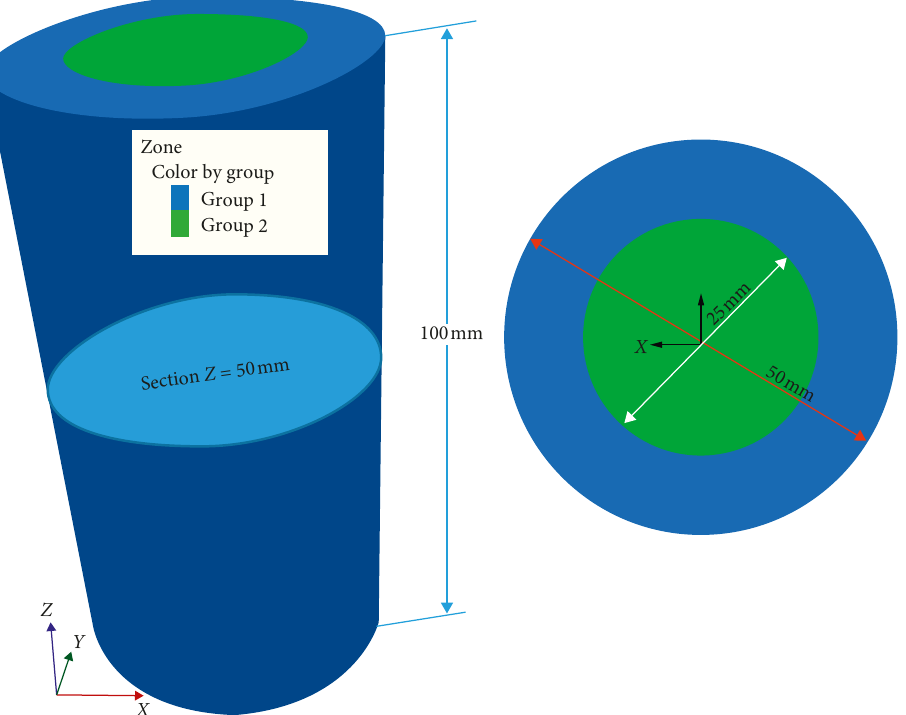
Figure 7: Numerical modeling of RCTMC